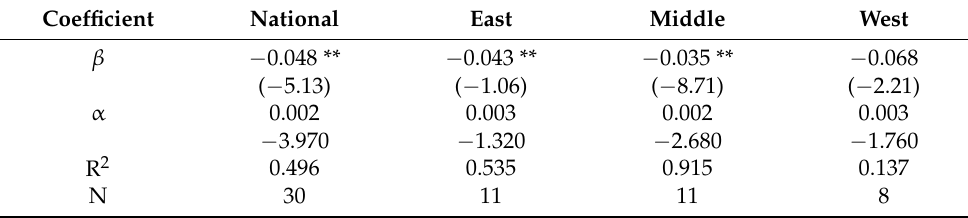
Table 7. National and regional absolute β convergence estimation results. Coefficient National